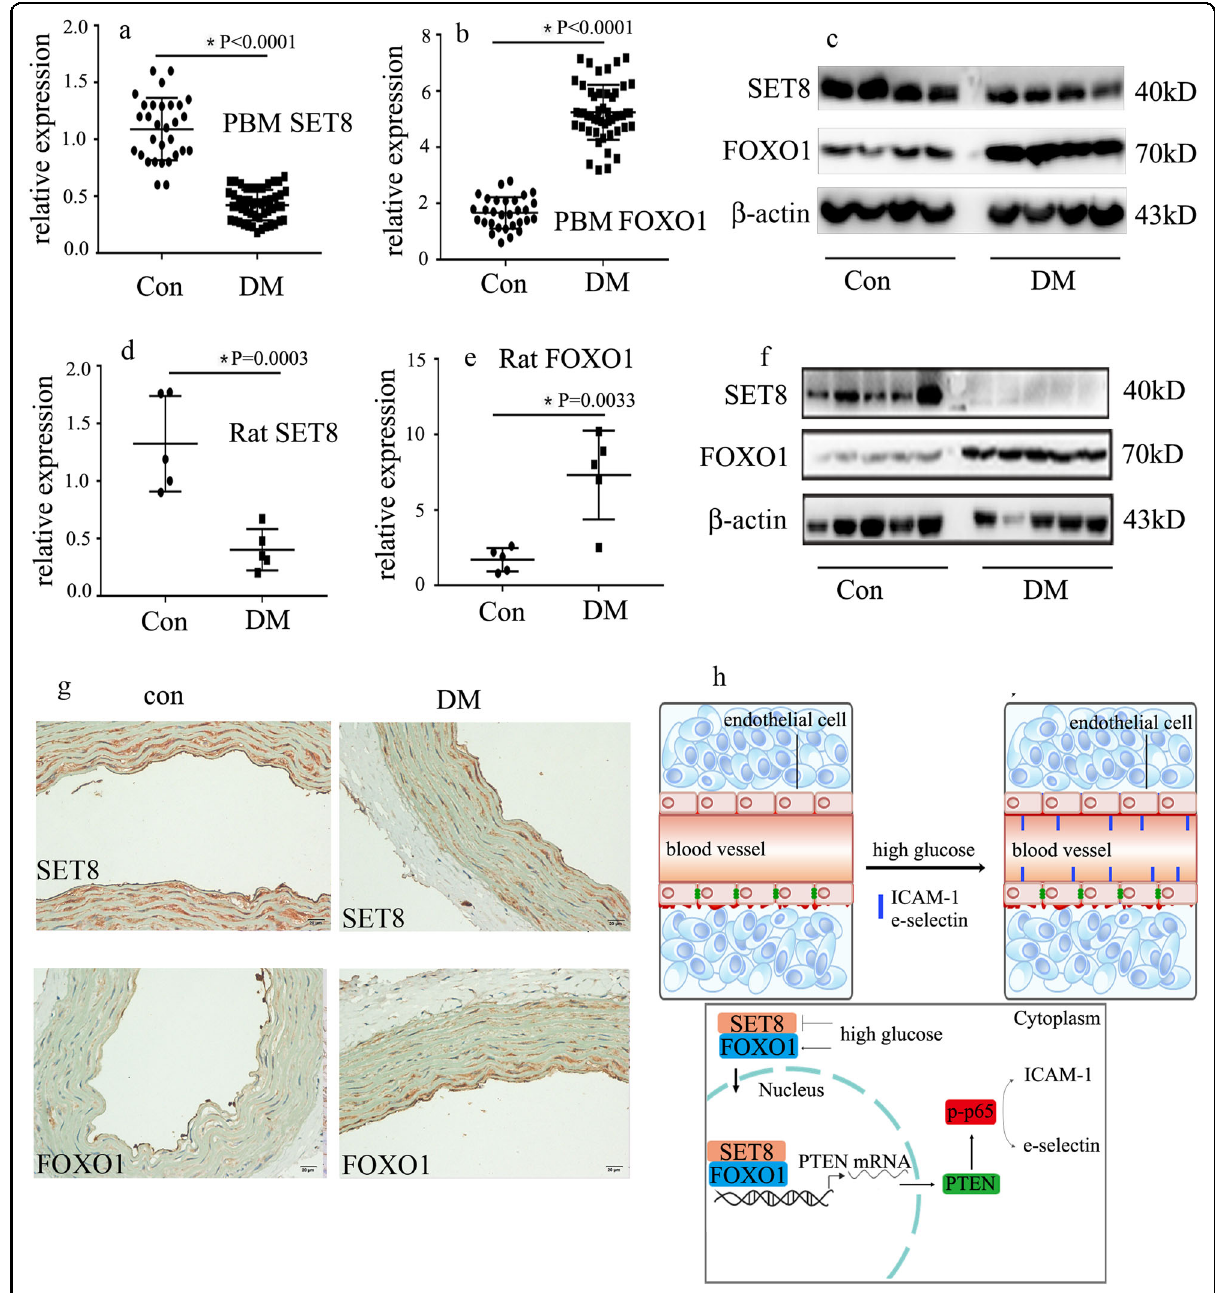
Fig. 7 The SET8 decrease and FOXO1 increase were con fi rmed in patients with diabetes and rats. a The mRNA expression of SET8 was examined by qPCR in the peripheral blood mononuclear cells of patients with diabetes and healthy volunteers (con: n = 30, DM: n = 50). b The mRNA expression of FOXO1 was examined by qPCR in peripheral blood mononuclear cells from patients with diabetes and healthy volunteers (con: n = 30, DM: n = 50). c Results from the western blot analysis of SET8 and FOXO1 expressions in peripheral blood mononuclear cells in patients with diabetes and healthy volunteers (con: n = 30, DM: n = 50). d The mRNA expression of SET8 was examined by qPCR in rat aortic tissues from the control group and the diabetic group ( n = 5/group). e The mRNA expression of FOXO1 was examined by qPCR in rat aortic tissues from the control group and the diabetic group ( n = 5/group). f Results from the western blot analysis of SET8 and PTEN expressions in rat aortic tissues from the control group and the diabetic group ( n = 5/group). g Immunostaining of SET8 and FOXO1 in rat aortic tissues from the control group and the diabetic group ( n = 5/group). Scale bar, 20 μ m. h Schematic representation of the working model. PBM peripheral blood mononuclear cells. * P < 0.05, compared with the control